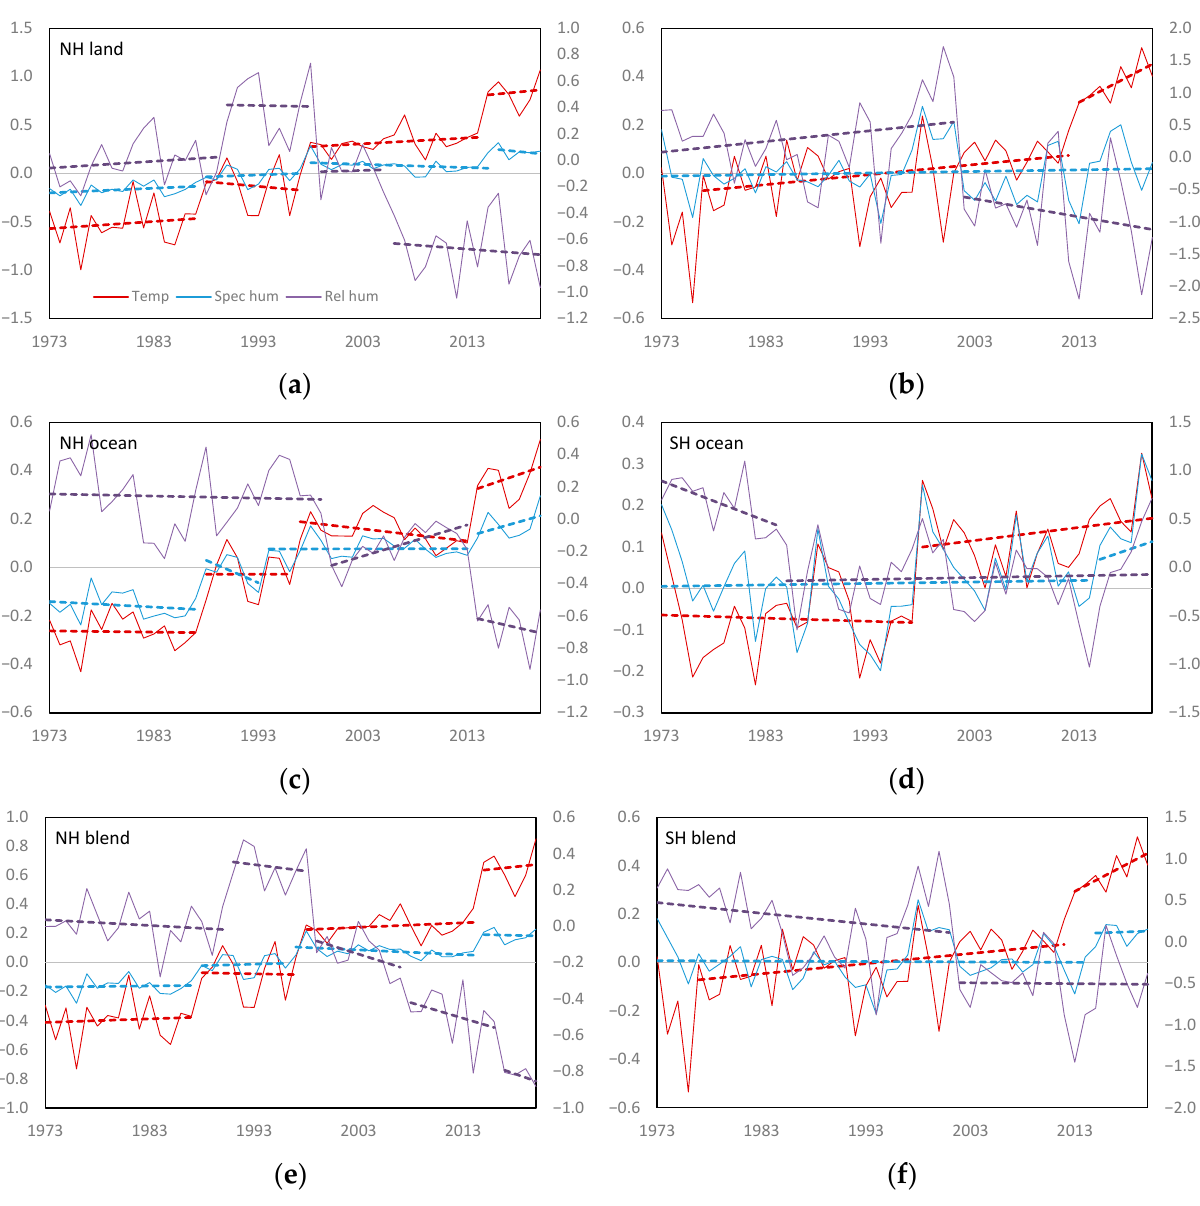
Figure 2. Annual anomalies (1981–2010) and regimes showing internal trends for northern and southern hemisphere average temperature (T), specific humidity (q) and relative humidity (RH) for ( a ) NH land, ( b ) SH land, ( c ) NH ocean, ( d ) SH ocean, ( e ) NH blend and ( f ) SH blend (Willett et al. 2020). Units are °C for temperature and g kg − 1 for specific humidity on the left axis and % for relative humidity on the right axis. Solid lines are annual values and dashed lines internal trends between shift points.